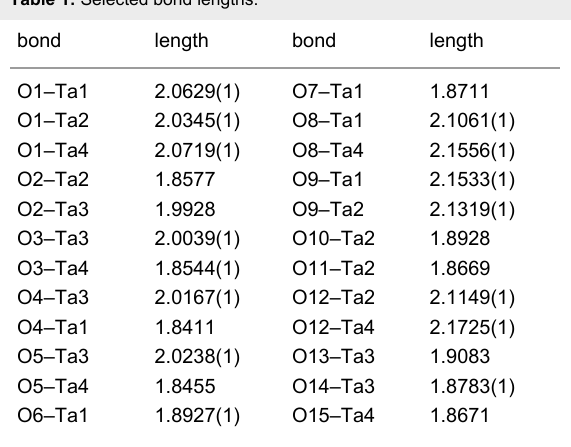
Table 1: Selected bond lengths.